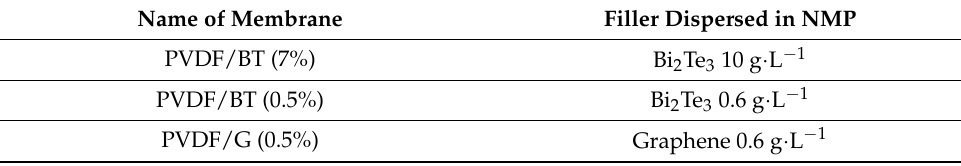
Table 1. List of prepared membrane with details about utilized